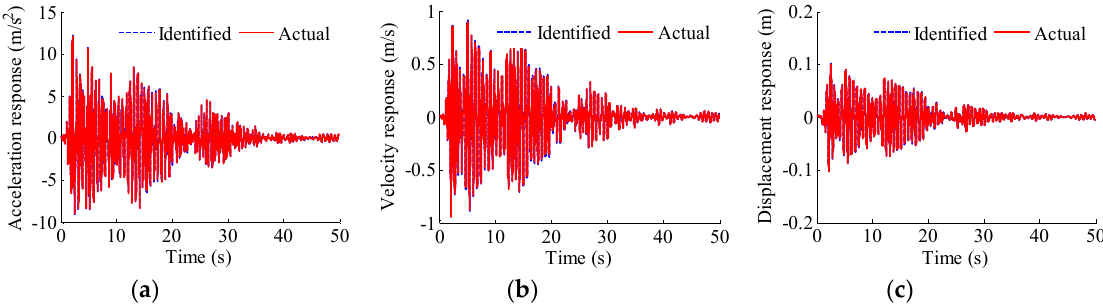
Figure 6. Comparison of the structural responses on the top floor (10% noise): ( a ) acceleration; ( b ) velocity; ( c ) displacement.